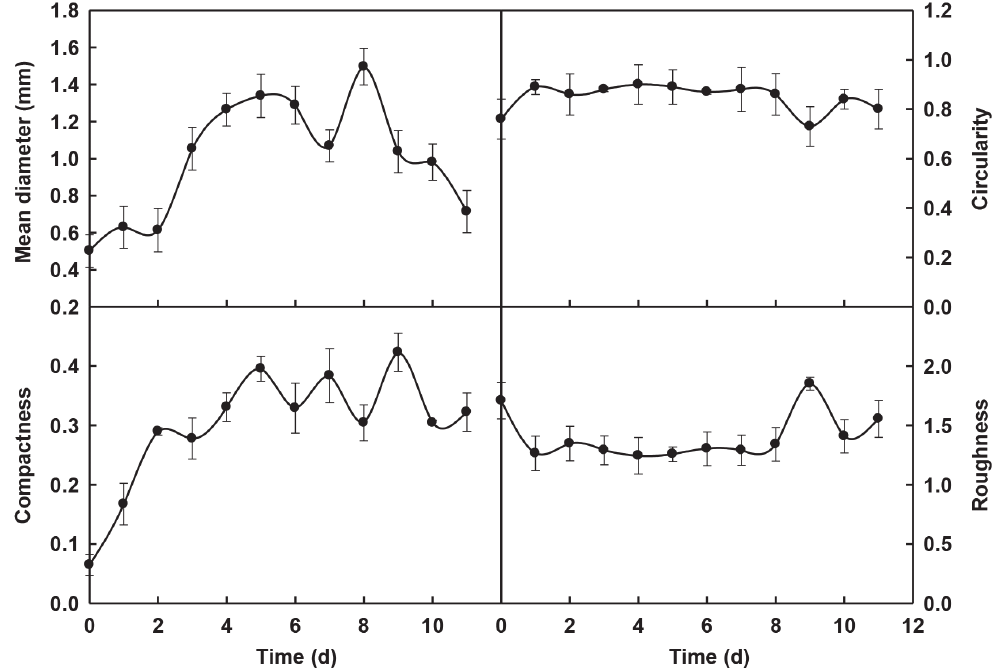
Fig. 4 - Mean diameter (A) , circularity (B) , compactness (C) and roughness (D) of P. geesteranus 5 # pellets growing in a stirred-tank